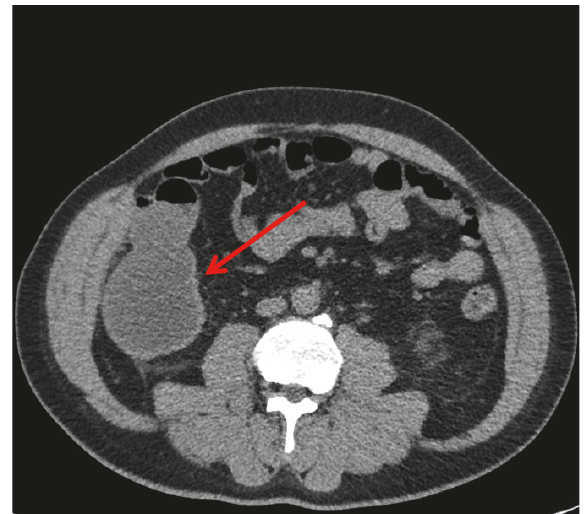
Figure 1: CT KUB showing the cystic swelling arising from the appendiceal stump (red arrow).